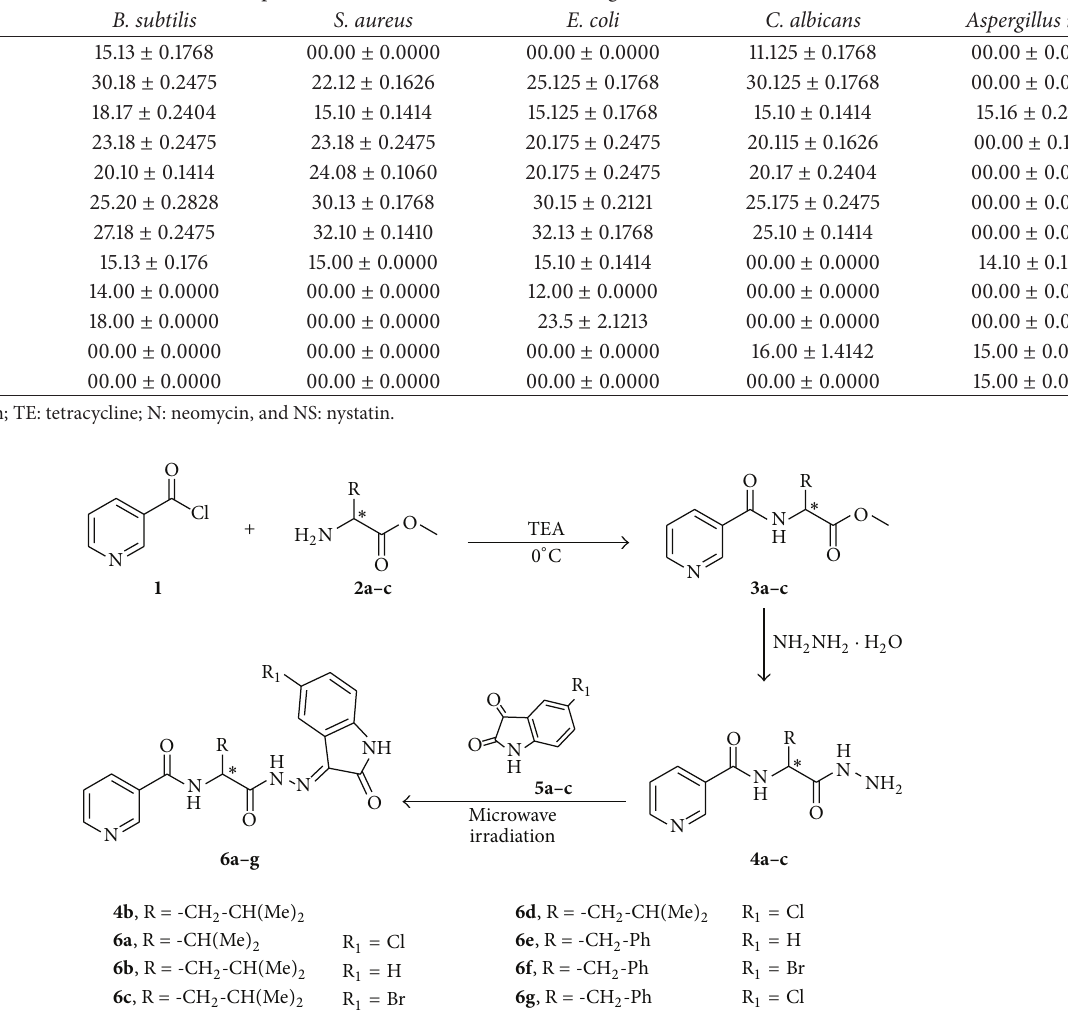
Table 1: Antimicrobial activity of the synthesized compounds at 10mg/mL. Comp. number